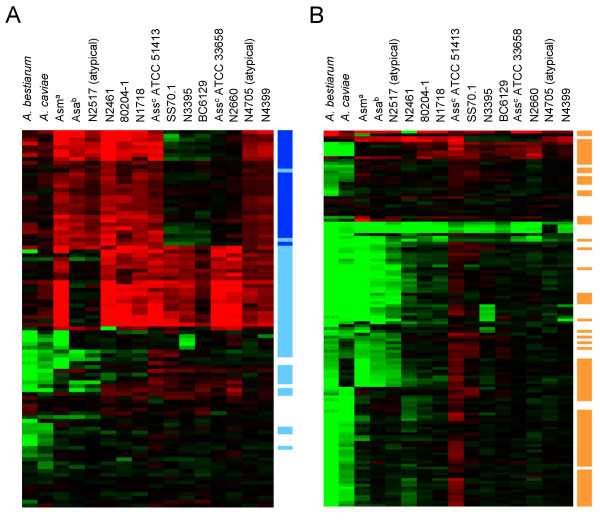
Variability of genes associated with plasmids and transposons in 16 Aeromonas strains and species. Red indicates genes with higher signal intensity for the tester than the control strain (higher copy number than in strain A449). Green indicates genes with lower signal intensity for the tester than the control (divergent in sequence or missing or at lower copy number). Gene order reflects results of hierarchical clustering of genes performed as described in Materials and Methods. The strains are ordered as in Figure 1, and unless otherwise noted, all other isolates are A. salmonicida subsp. salmonicida. aAsm – A. salmonicida subsp. masoucida, bAsa – A. salmonicida subsp. achromogenes, cAss – A. salmonicida subsp. salmonicida. (A) All genes from the plasmid functional category. The blue bars (both light and dark) indicate genes found on plasmid 5, and the dark blue bars correspond to predicted TTSS genes. (B) All genes from the transposon functional category. The orange bars indicate genes with strong sequence similarity to known transposases.